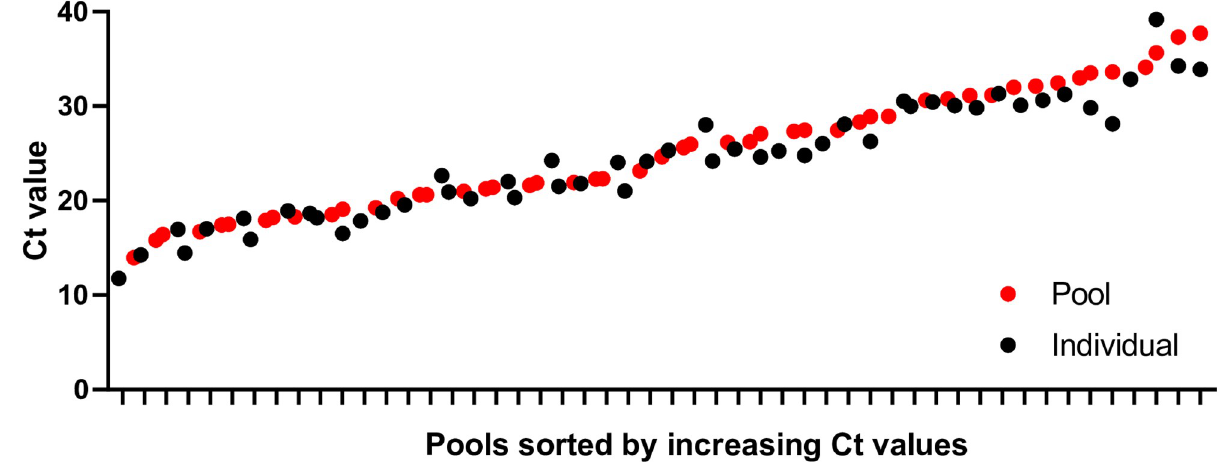
Fig 4. Graph showing Ct values for the detection of SARS-CoV-2 E gene in positive individual and pooled self-collected samples.